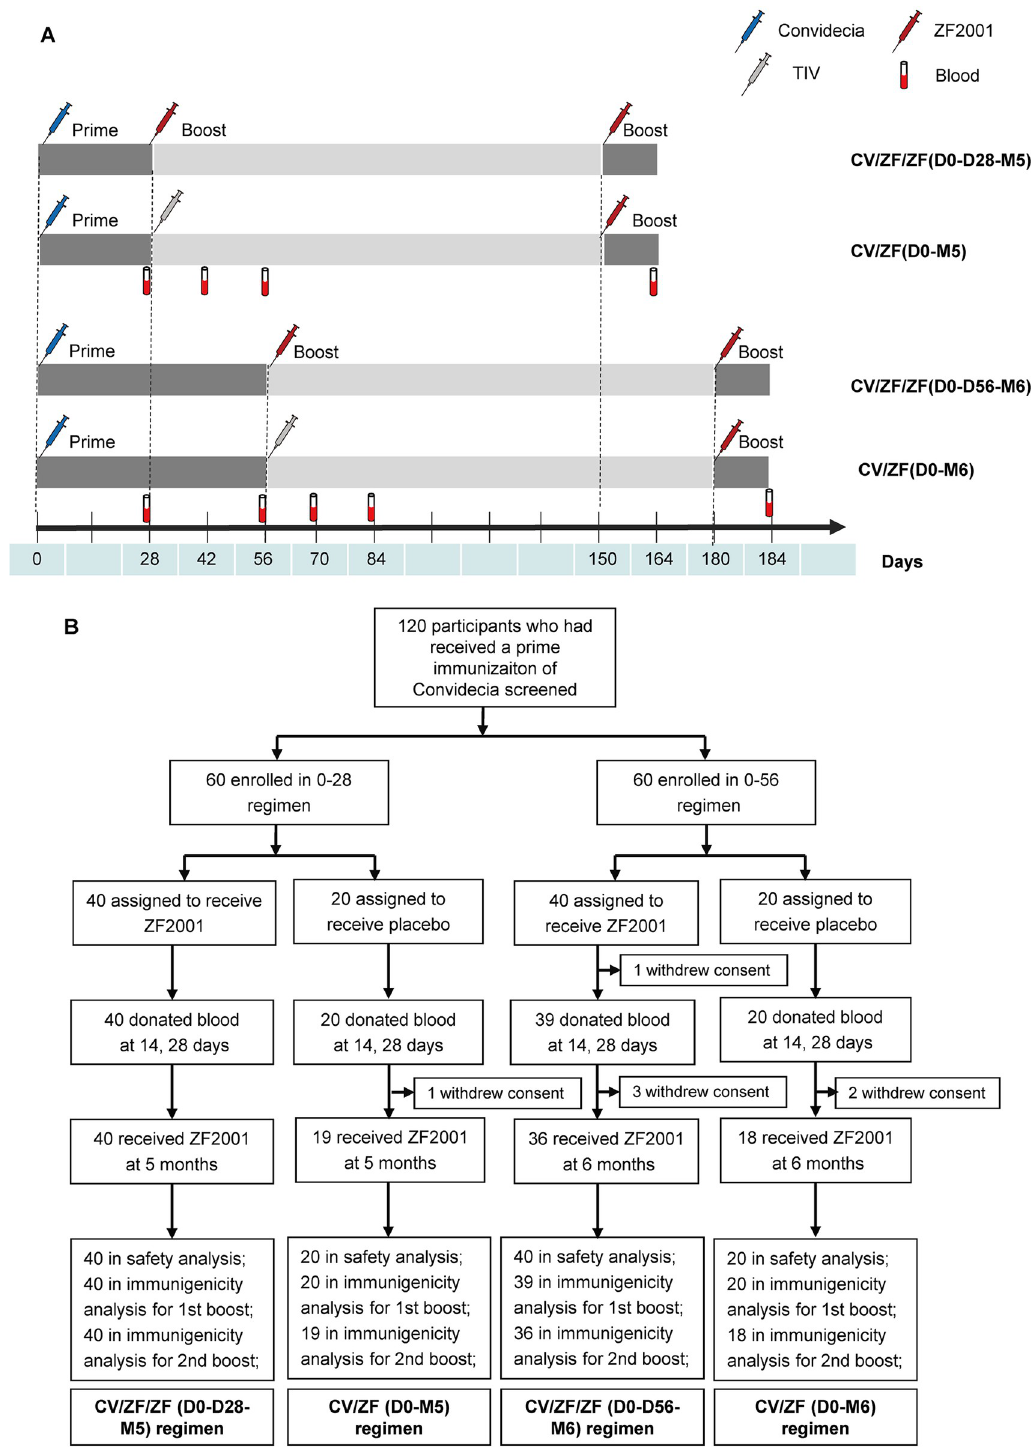
Fig 1. Study design and trial profile. AU : AbbreviationlisthavebeencompiledforthoseusedinFigs 1 (cid:0) 5 andS 1 (cid:0) S 5 : Pleaseverifythatallentriesarecorrect : (A) Immunization schedule and serum collection in 4 prime-boost regimens. CV/ZF/ZF (D0-D28-M5) refers to receiving Convidecia/ZF2001/ZF2001 at day 0, day 28, and month 5 (day 150); CV/ZF (D0-M5) refers to receiving Convidecia/TIV/ZF2001 at day 0, day 28, and month 5 (day 150); CV/ZF/ZF (D0-D56-M6) refers to receiving Convidecia/ZF2001/ZF2001 at day 0, day 56, and month 6 (day 180); and CV/ZF (D0-M6) refers to receiving Convidecia/TIV/ ZF2001 at day 0, day 56, and month 6 (day 180). For CV/ZF/ZF (D0-D28-M5) and CV/ZF (D0-M5) regimen, blood